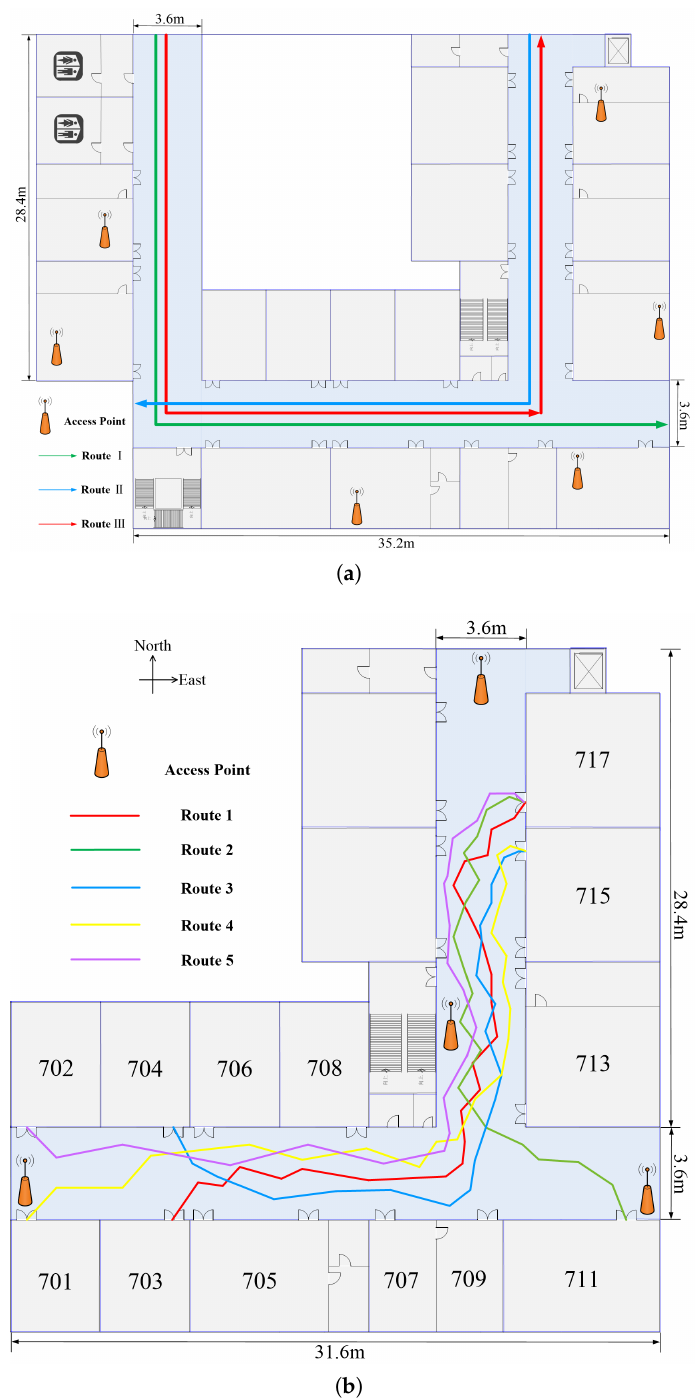
Figure 5. Graphical representation of the corridor. ( a ) Area A with three routes: training paths are represented as Routes I and II and testing paths are represented as Route III. Ten different crowdsourcing user trajectories qwew acquired for each route. ( b ) Area B with five routes: Training paths are represented as four types of routes with a total of 20 trajectories, including five trajectories of Route 1 (from Room 717 to Room 703), five trajectories of Route 1 (from Room 703 to Room 717), five trajectories of Route 2 (from Room 717 to Room 711), and five trajectories of Route 3 (from Room 715 to Room 704). The eight testing trajectories consist of two trajectories of Route 2 (from Room 711 to Room 717), three trajectories of Route 4 (from Room 701 to Room 715), and three trajectories of Route 5 (from Room 702 to Room